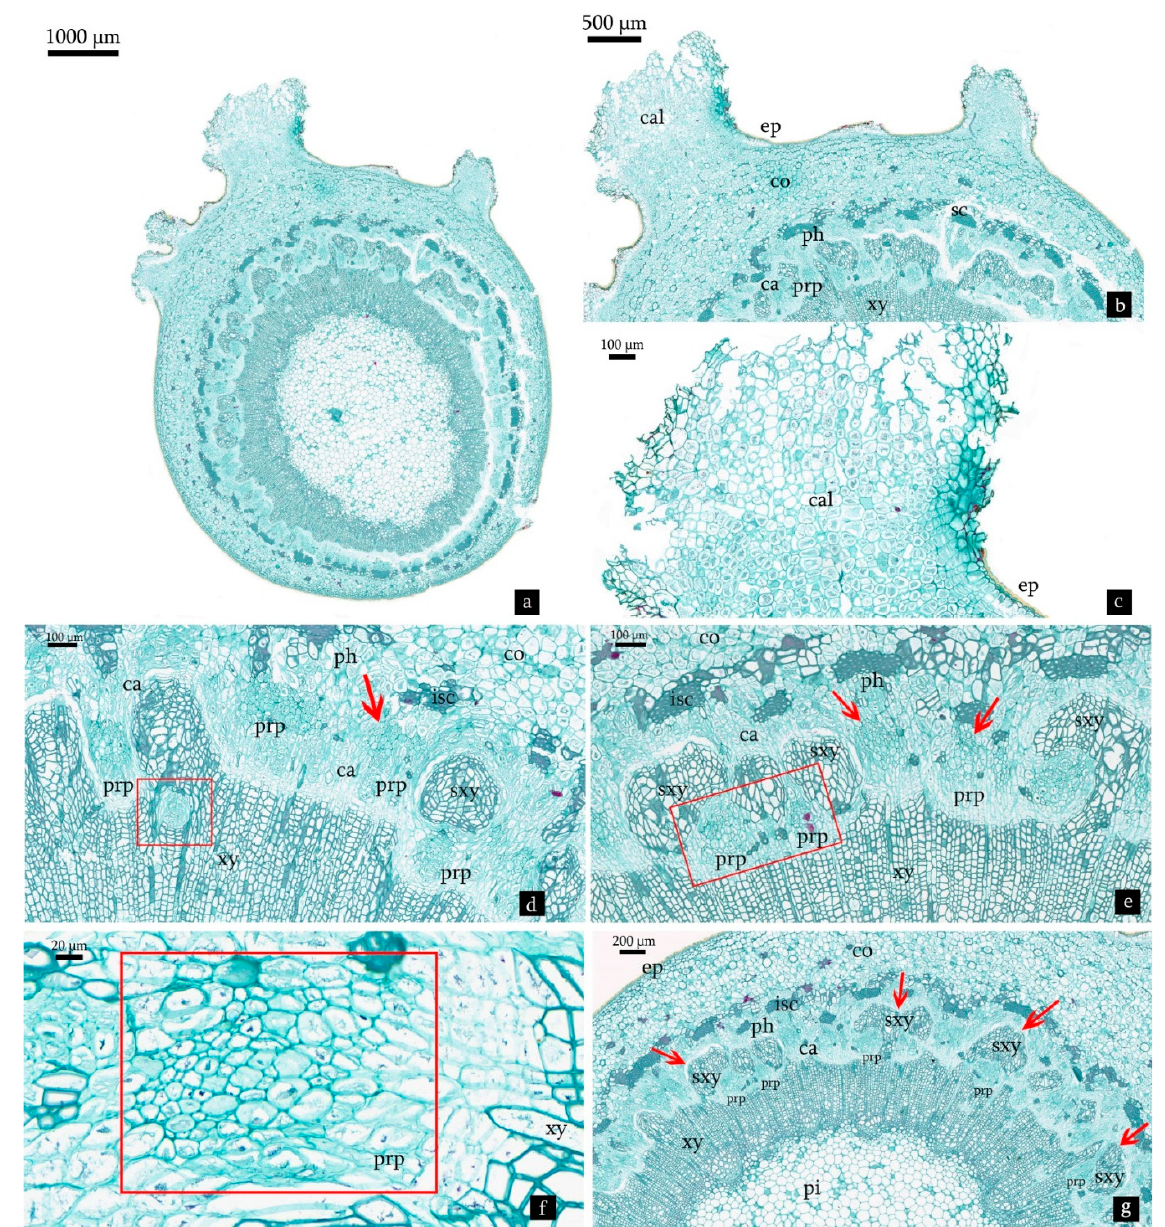
Figure 6. Transverse sections derived from cuttings treated with NAA:IBA (2:1) on the 13th day after planting. ( a ) Histological structure of cutting treated with NAA:IB (2:1). ( b , c ) Callus tissue on the epidermis, showing cortical cell proliferation. ( d ) Two sources of adventitious root primordia in M. wufengensis cuttings. Red frame shows the root meristem cells initiated from xylem. Red arrow shows the root primordia precursors initiated from cambium zone. ( e ) Two types of root primordia precursors in M. wufengensis cuttings. Red frame shows the root primordia precursors initiated from xylem. Red arrow shows the root primordia precursors initiated from cambium zone. ( f ) Cells of root primordia precursors were more densely stained than the cells neighbor and their nuclei became more pronounced. ( g ) The scattered xylem squeezed by the proliferation of meristematic cells. Abbreviations: co = cortex; sc = sclerenchyma; ph = phloem; ca = cambium; xy = xylem; pi= pith; pir = pith ray; isc = intermittent sclerenchyma; cal = callus tissue; prp = precursor of adventitious root primordia; sxy = scattered